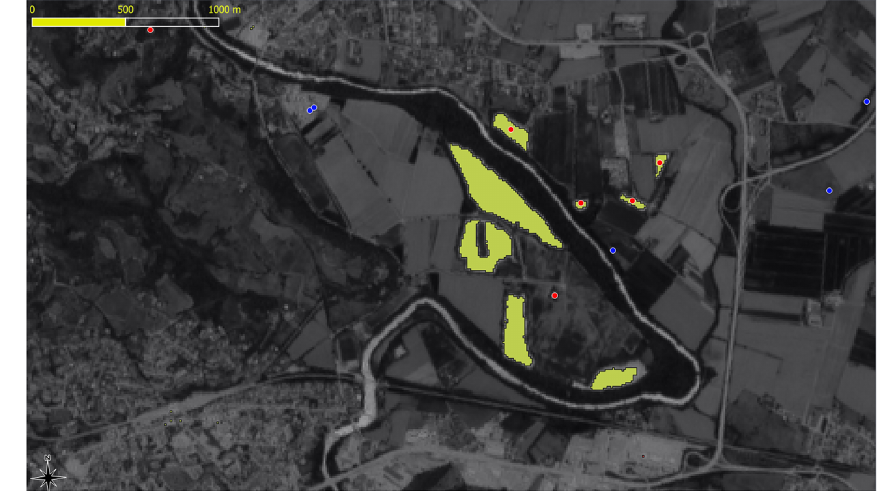
Figure 9. Identification of new reservoir with the